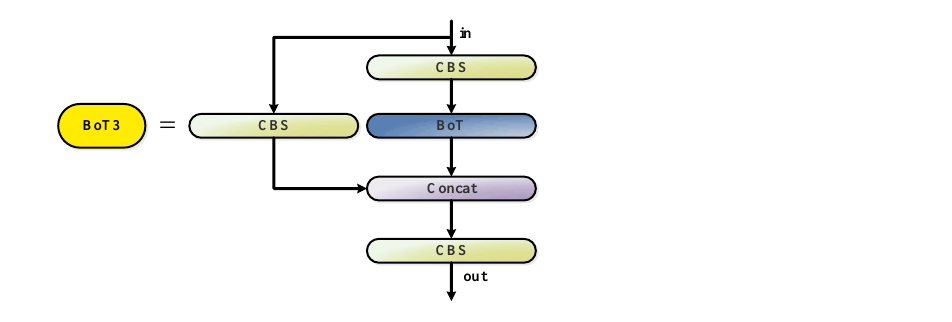
Figure 8. BoT3 added to the Neck of YOLOv5. BoT3 replaces two CBS blocks of the C3 block with the BoT block (Figure 9).